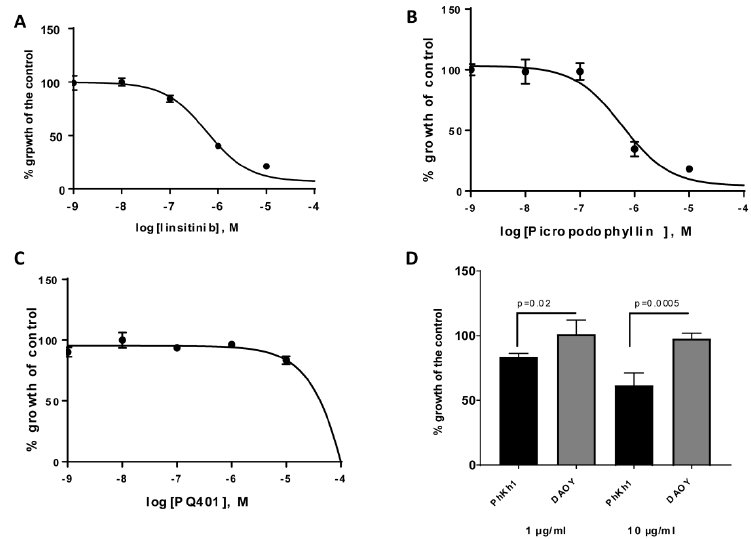
Figure 3. HGNET-BCOR is sensitive to IGF1R inhibition: ( A – C ) PhKh1 cells were treated with the indicated IGF1R inhibitors at concentrations from 1 nM to 100 µ M. The logarithm of the molarity (M) is displayed on the X-axis. The percent of viable cells compared to the control treated with vehicle alone is shown on the Y-axis. The data were fitted to a sigmoidal dose–response curve using GraphPad software. A representative experiment of three independent experiments is shown. ( D ) PhKh1 and DAOY cells were incubated with a blocking anti-IGF1R antibody at the indicated concentration, and cell proliferation was measured. The percent of viable cells compared to the control treated with vehicle alone is shown on the Y-axis. Statistics were performed using Student’s t -test. A representative experiment of three independent experiments is